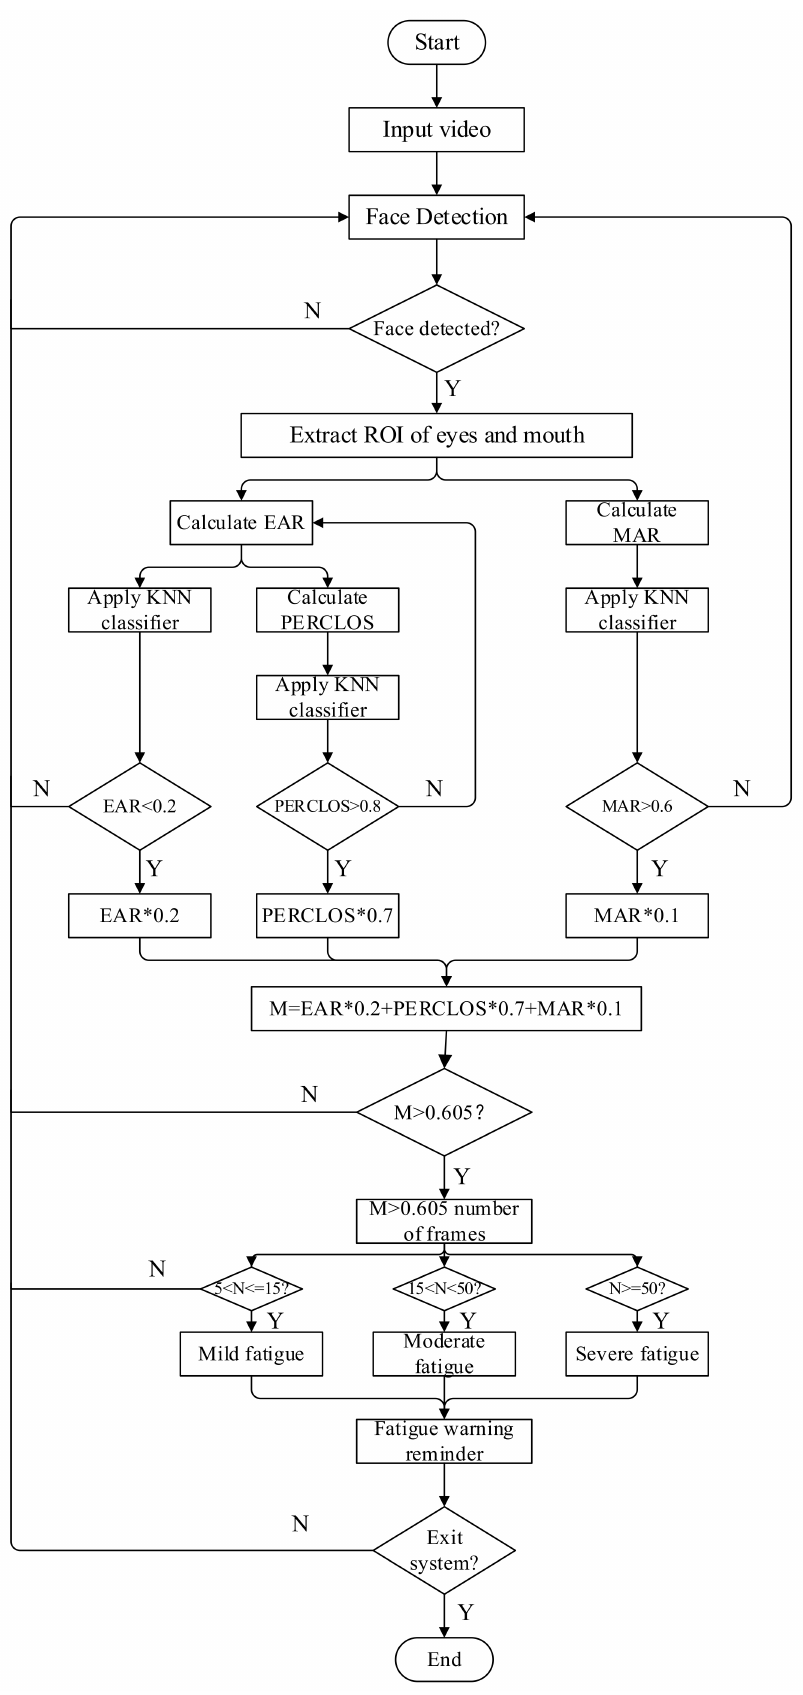
Figure 6. Online detection of driver